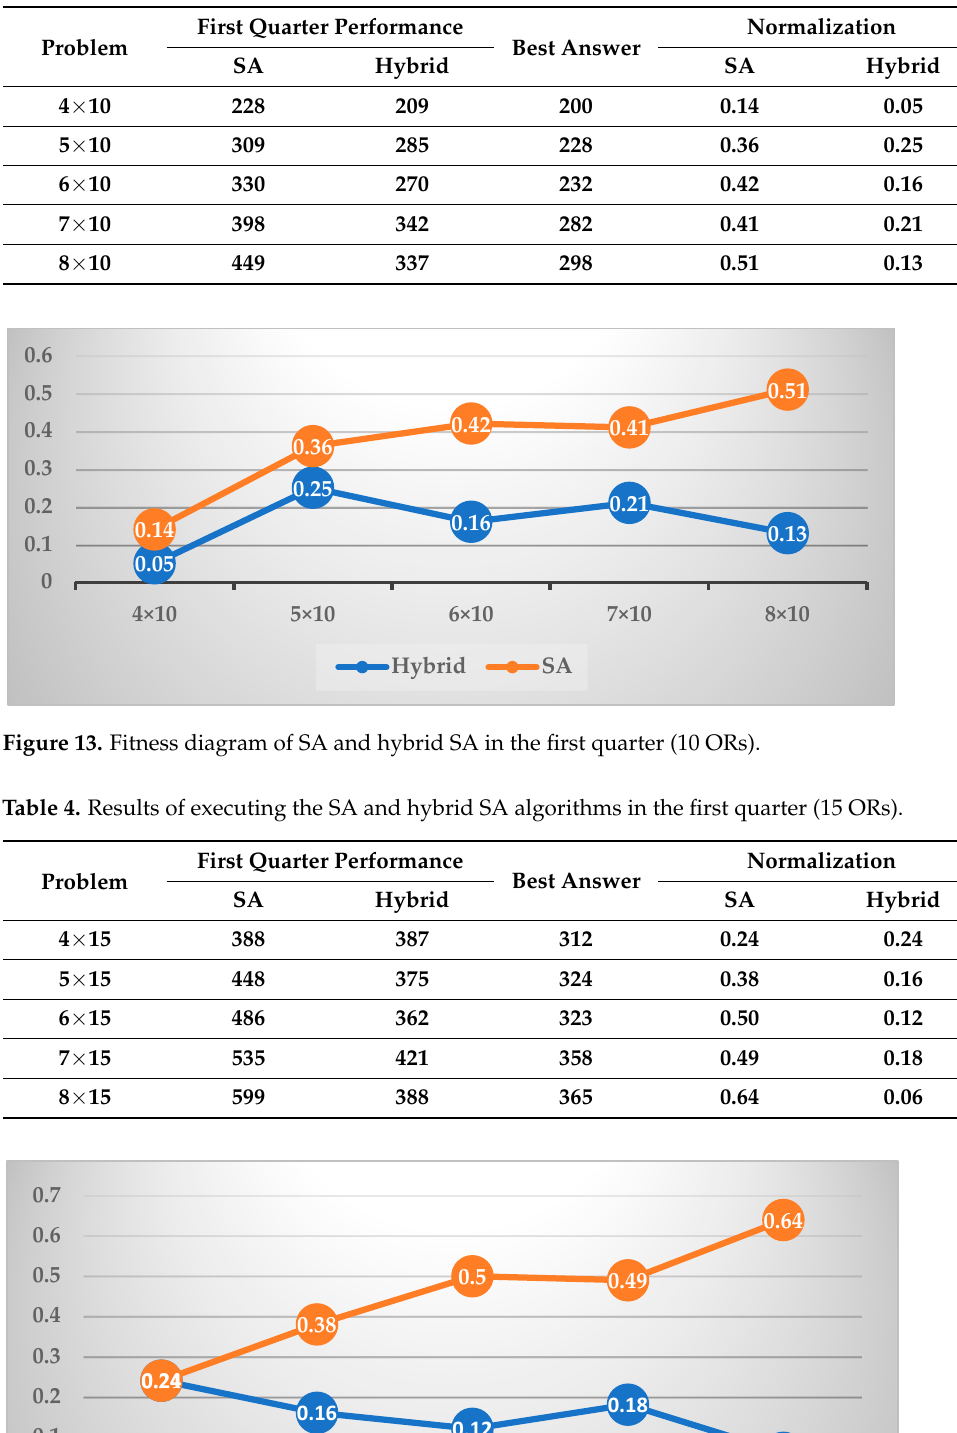
Table 3. Results of executing SA and hybrid SA algorithms in the first quarter (10 ORs).